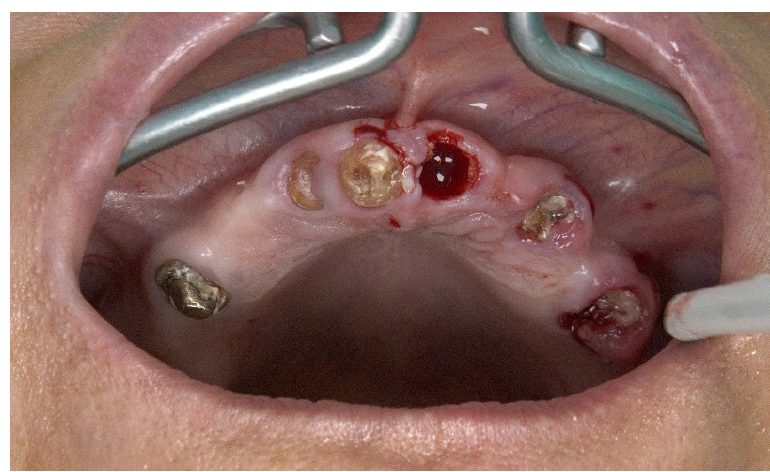
Figure 1. Preoperative orthopantomography of the maxilla.